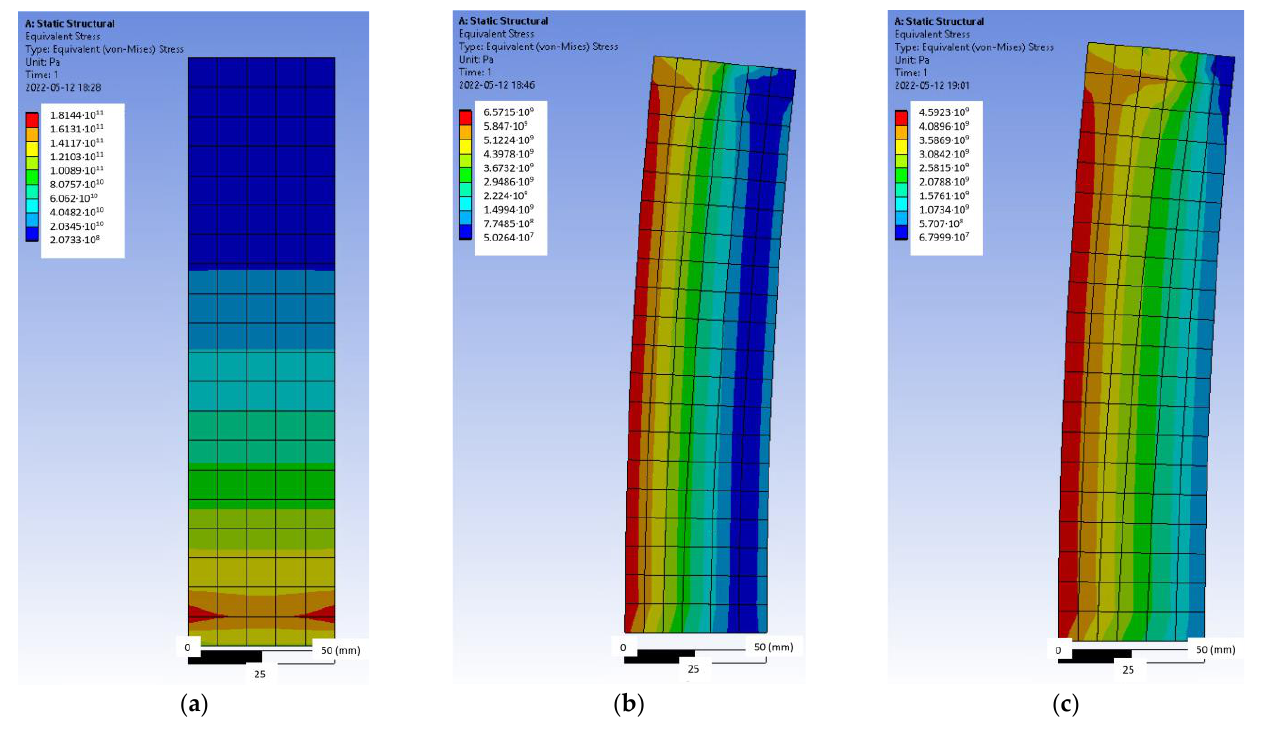
Figure 8. Tensile test simulation with Ansys: ( a ) pressure and tension simultaneously, ( b ) eccentric load action, e = 0.25 b f , and ( c ) eccentric load action, e = 0.125 b f.